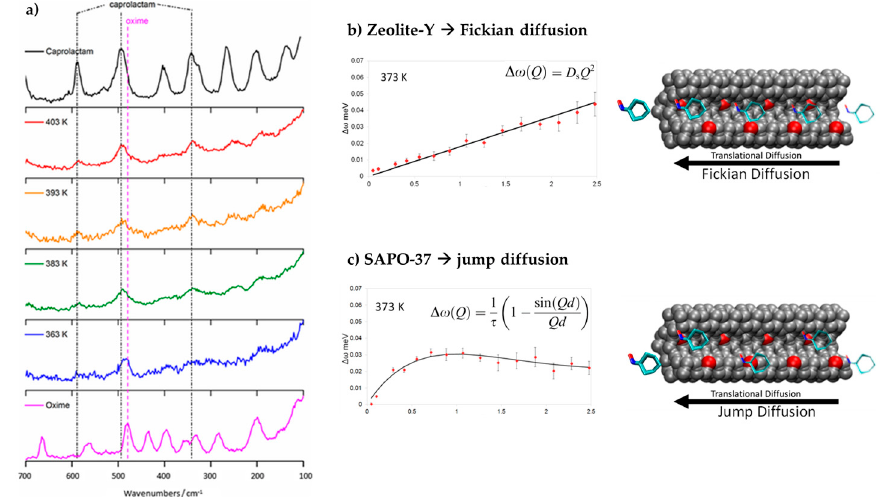
Figure 8. In a physical mixture of SAPO-37 and cyclohexanone oxime, INS studies revealed that ε -caprolactam was formed significantly below the reaction temperature of 130 °C ( a ) [80]. QENS studies revealed that cyclohexanone oxime, in a physical mixture with Zeolite-Y (FAU), exhibits smooth, Fickian diffusion ( b ), whereas in SAPO-37, the oxime is found to undergo jump diffusion due to favourable interaction with the internal acid sites ( c ) (modified from references [79,80]).